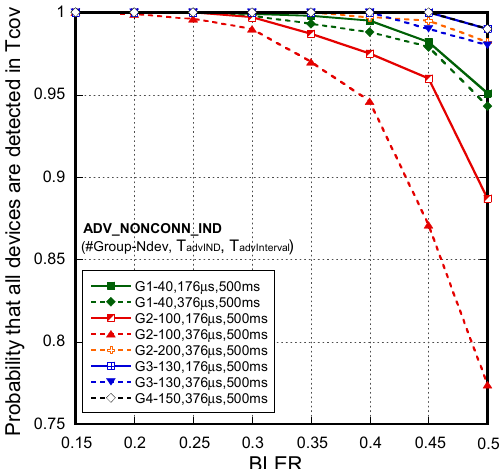
Figure 10. Non-connectable undirected advertisement scheme. Probability that all devices are detected under a single scanner coverage. Comparison between Group #1 ( 1 ), #2 ( 2 ), #3 ( 3 ) and #4 ( 4 ). Cases without a 100% of detection probability.